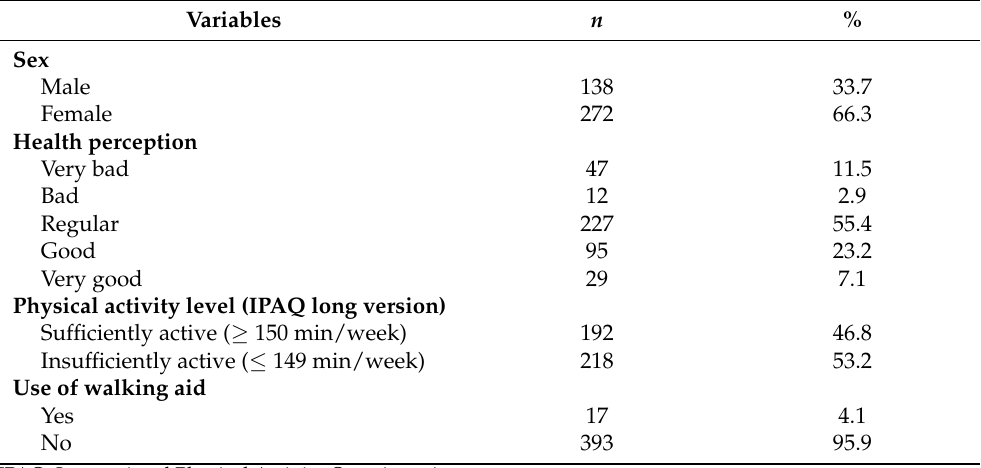
Table 1. Characteristics of the community-dwelling older adults (Macap á , Amap á , 2017) ( n =